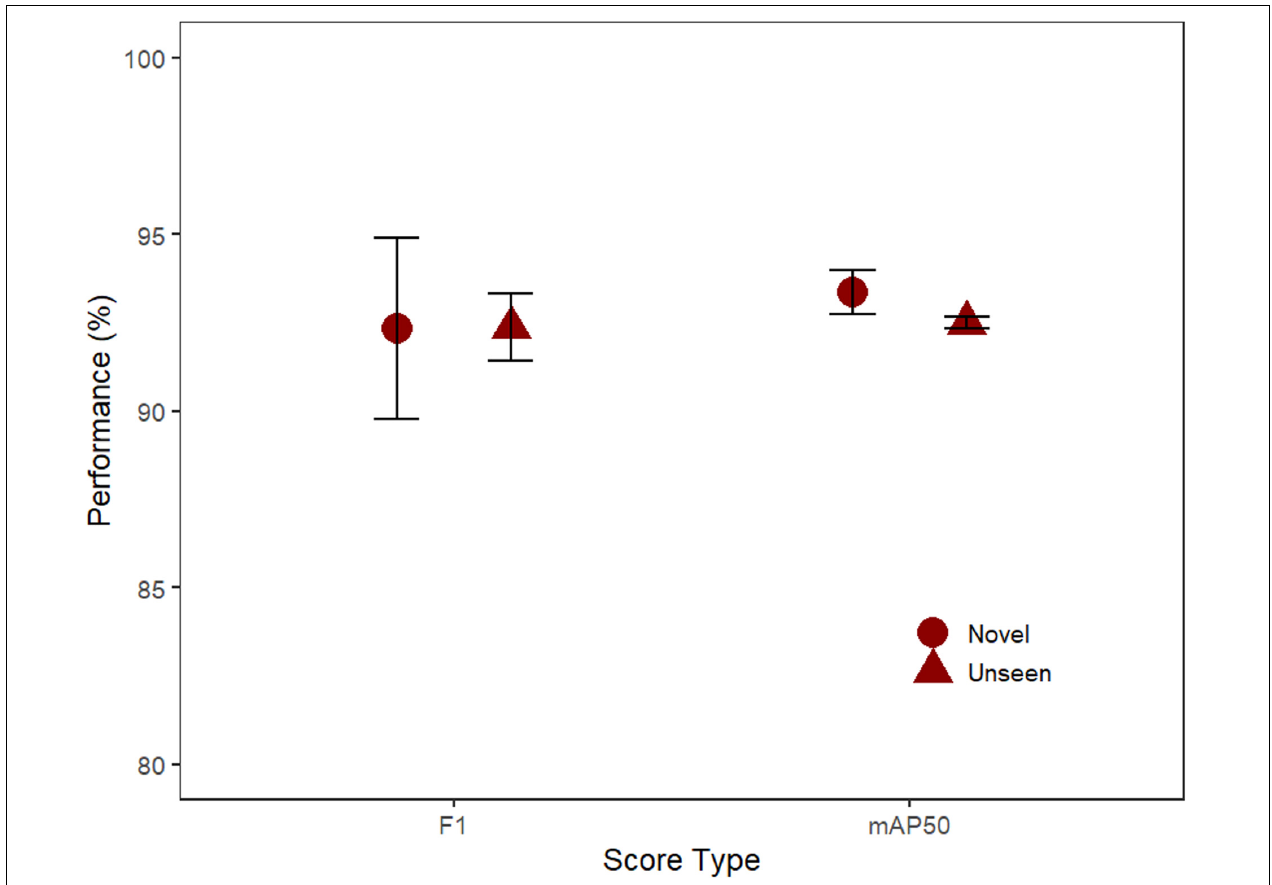
FIGURE 3 | The performance of the three model’s F1 and mAP50 scores (mean, SE) for the unseen test footage from the same location and novel footage (Unseen: 32 videos, Novel: 32 videos).